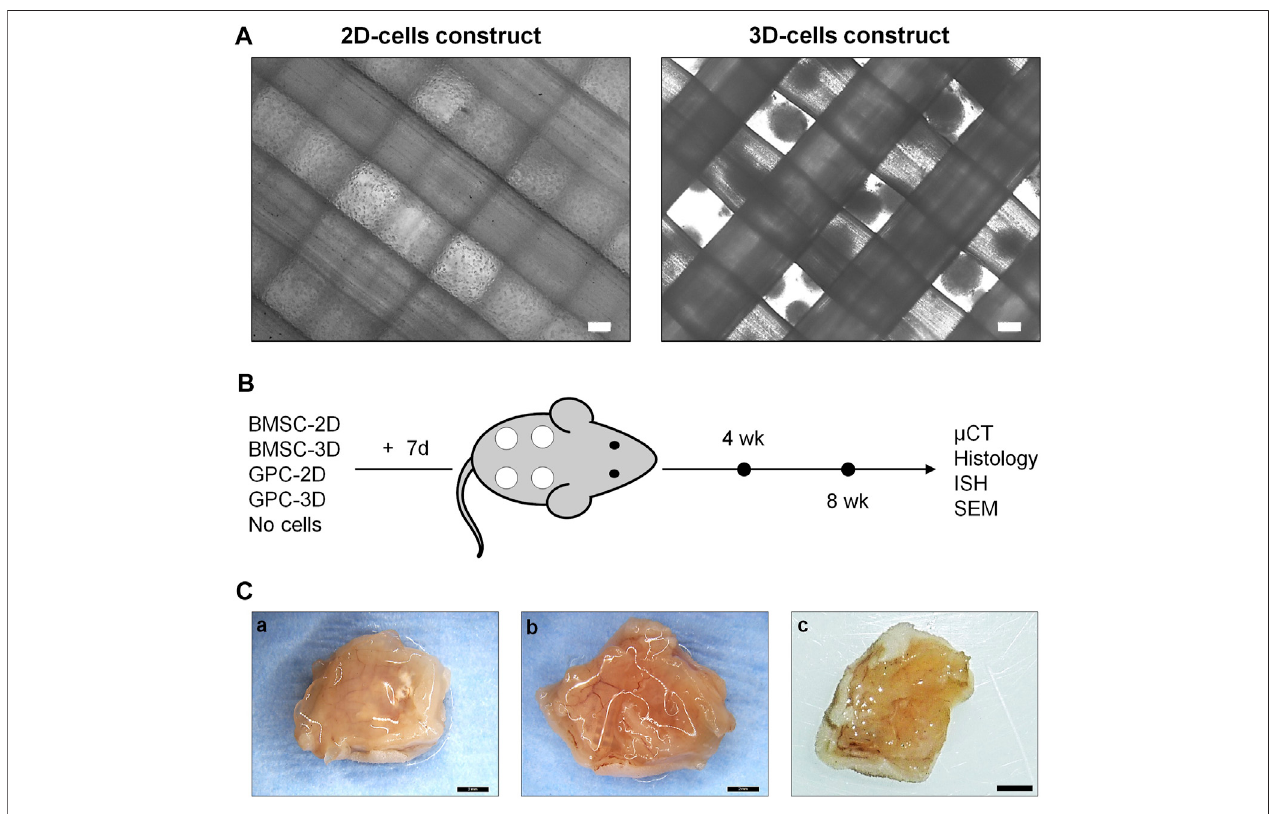
FIGURE 1 | Study design. (A) Representative phase microscopic images of 2D (single cells) and 3D (spheroids) cell constructs; scale bars 100 μ m. (B) Schema of study design, experimental groups and outcomes; constructs were cultured in vitro in osteogenic induction medium for 7 days prior to implantation (+7 days). (C) Representative macroscopic images of 8-weeks tissue specimens containing BMSC (a), GPC (b) or cell-free constructs (c); scale bars 2 mm.